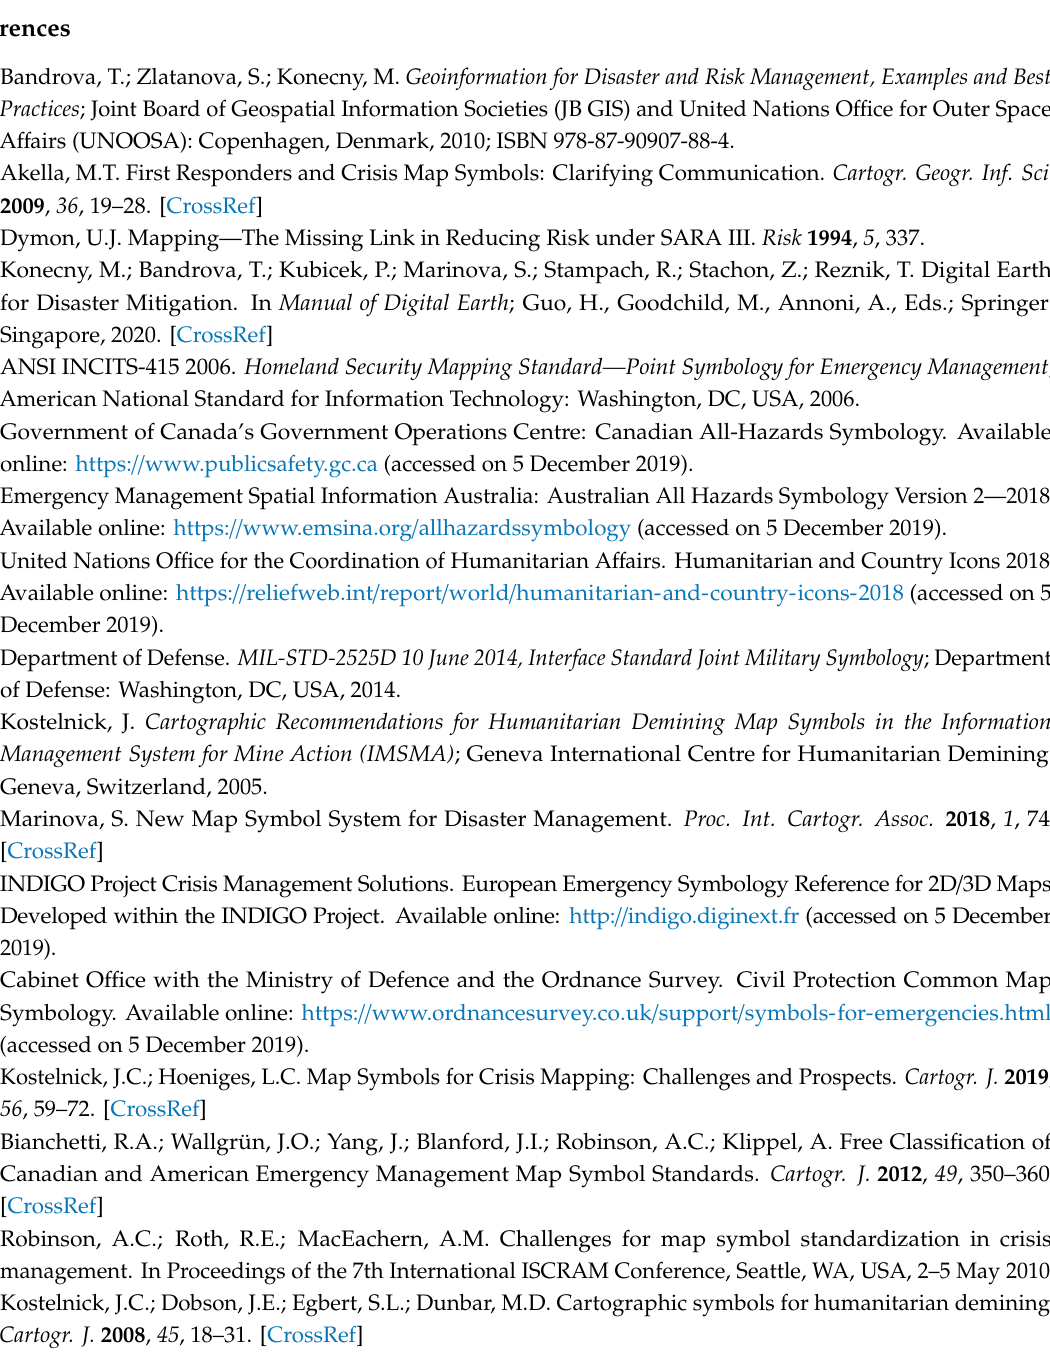
Supplementary Materials: Table S1: Results of a comparative study of six publicly available cartographic symbol sets for crisis mapping, Repository R1: Digital repository of cartographic symbols covered by the